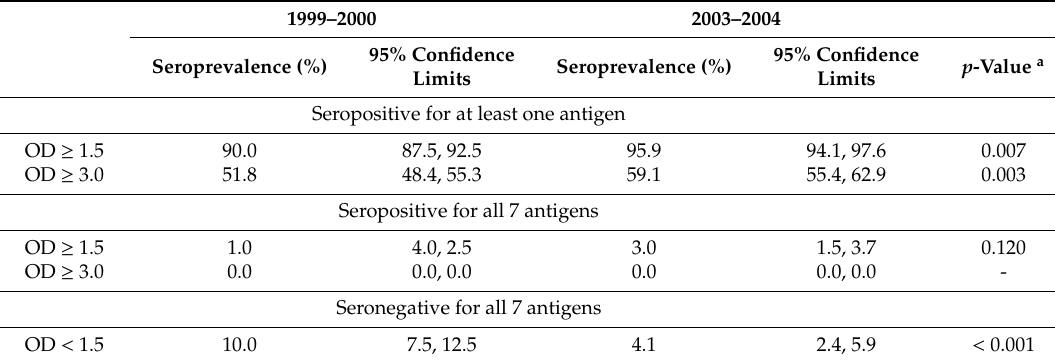
Table 1. Population-adjusted overall norovirus seroprevalence in USA adults aged 16 to 49 years.